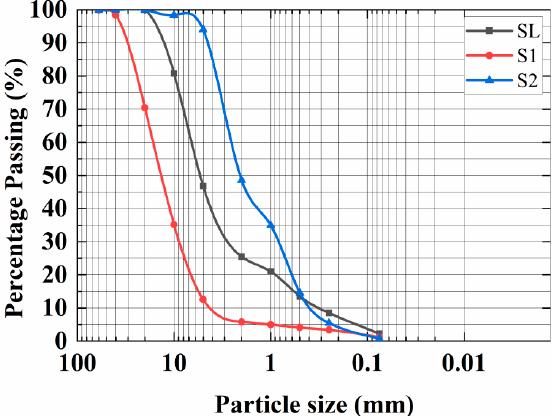
Figure 2. The grading curves of soil and SL used in this study.